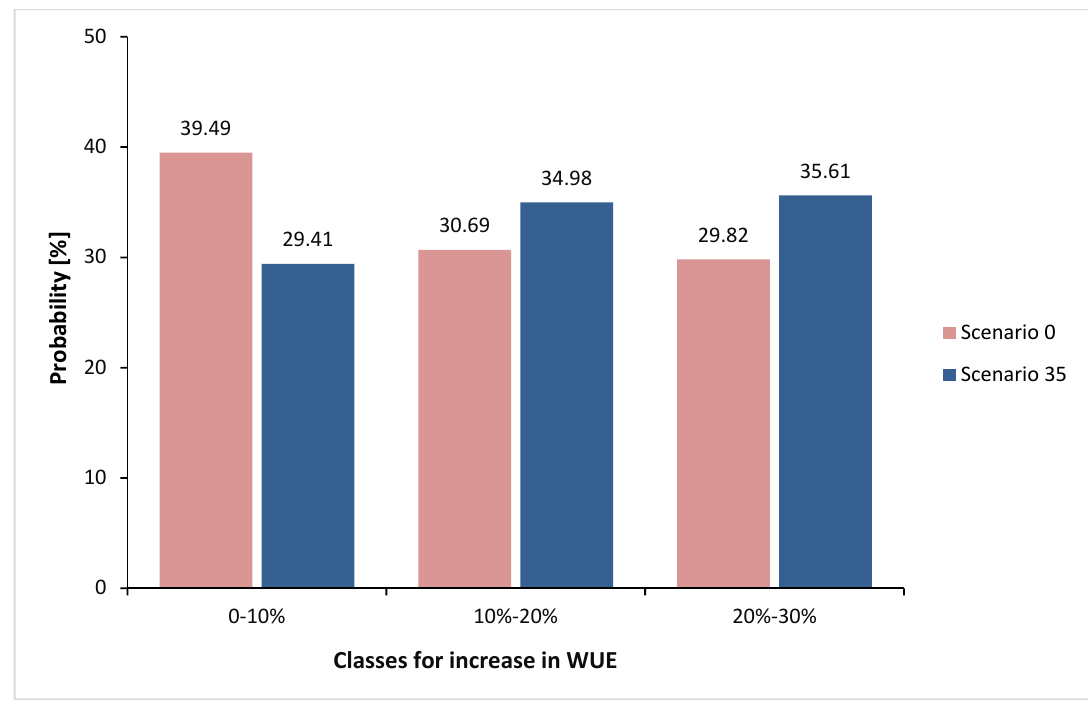
Figure 3. Probability value of the increase in WUE under baseline conditions (scenario 0) and the best combination of policy measures (scenario